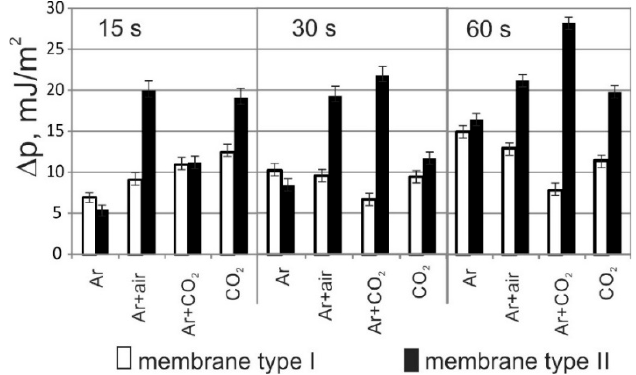
Figure 4 The effect of the used gas and exposition time on the polar component (∆p). Discharge Figure 4. The effect of the used gas and exposition time on the polar component ( ∆ p). power = 20 W. Discharge power = 20